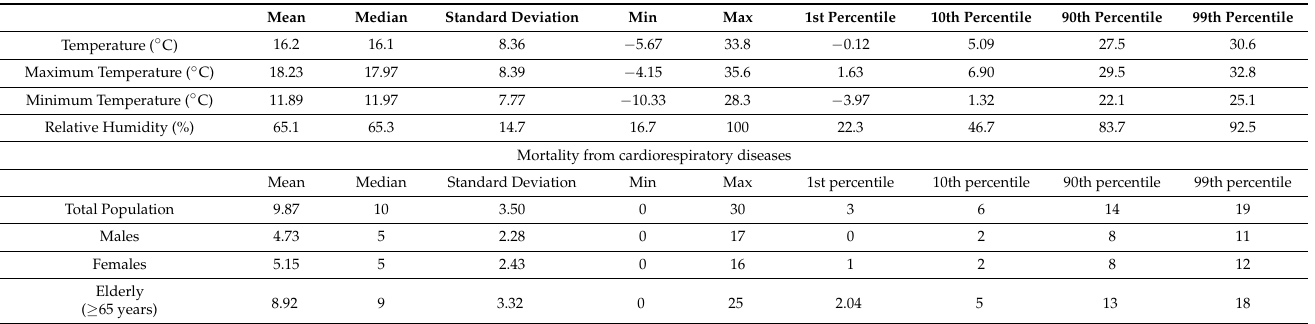
Table 1. Descriptive statistics of the daily meteorological variables and daily deaths from cardiorespi- ratory diseases in EMT from 1999 to